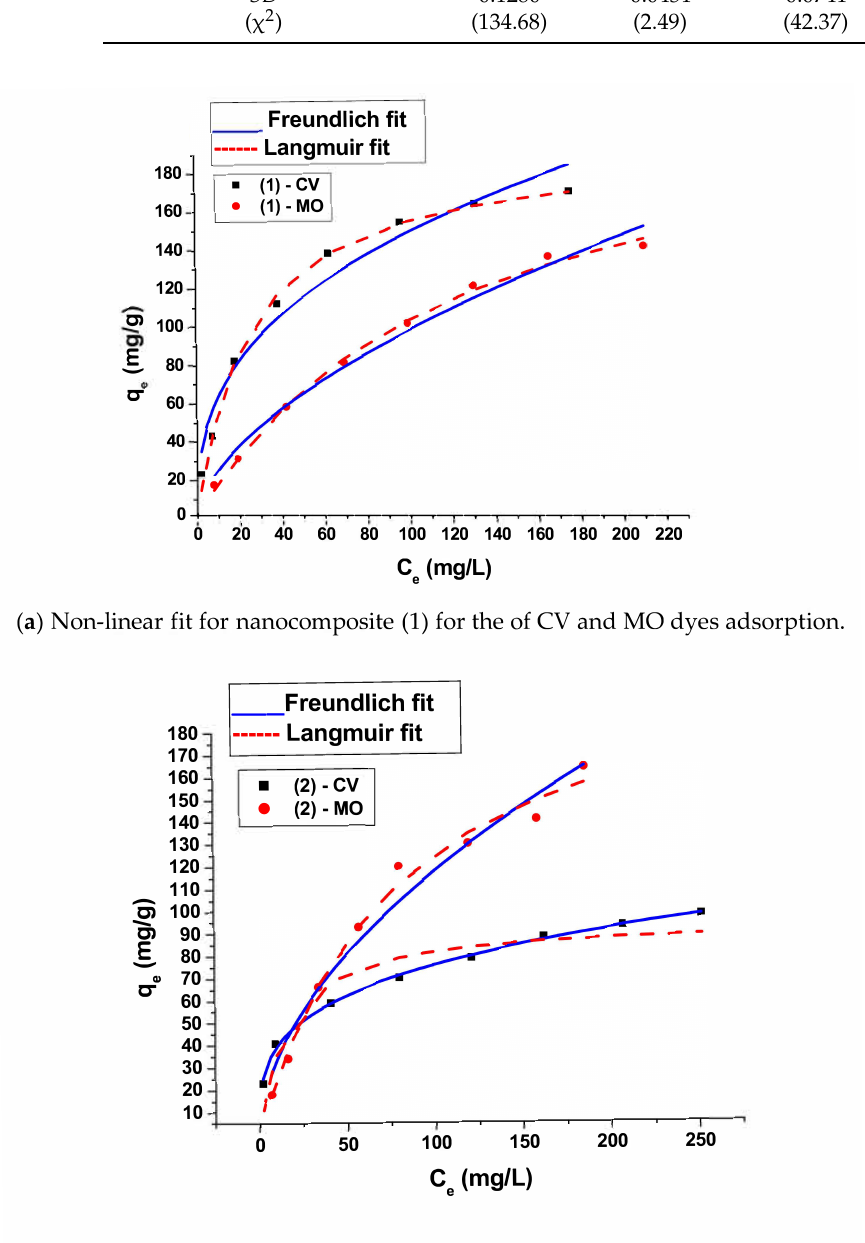
(b) Non-linear fit of nanocomposite (2) for the of CV and MO dyes adsorption. Figure 11. Langmuir and Freundlich models non-linear fit for the adsorption of CV and MO dyes, ( a ) by nanocomposite (1) and ( b ) by nanocomposite